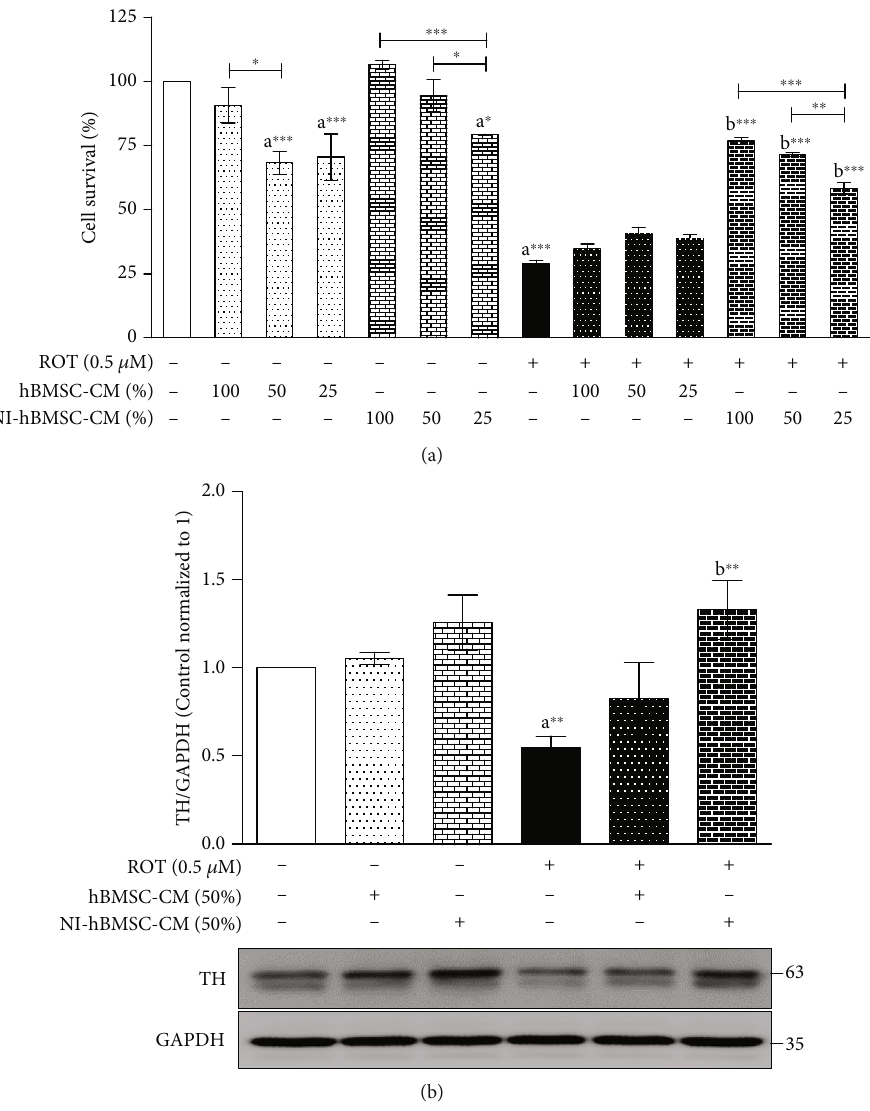
Figure 1: (a) SH-SY5Y cells incubated with the absence or presence of ROT (0.5 μ M) for 48h were treated with hBMSC-CM or NI-hBMSC- CM at 100 or 50 or 25% during the last 24h, and cell survival was assessed by the trypan blue assay. Data are the mean ± SEM of three independent experiments and analyzed by one-way analysis of variance (ANOVA) followed by Tukey ’ s post hoc test. Statistical signi fi cance: a compared with control; b compared with ROT; ∗ p < 0 : 05 and ∗∗∗ p < 0 : 001 . (b) Cells incubated with the absence or presence of ROT (0.5 μ M) for 48h were treated with hBMSC-CM (50%) or NI-hBMSC-CM (50%) during the last 24 h and assessed for TH and GAPDH by Western blotting. Each picture is representative of three independent experiments. Data are the mean ± SEM of three independent experiments and analyzed by one-way analysis of variance (ANOVA) followed by Tukey ’ s post hoc test. Statistical signi fi cance: a compared with control; b compared with ROT; ∗∗ p < 0 : 01